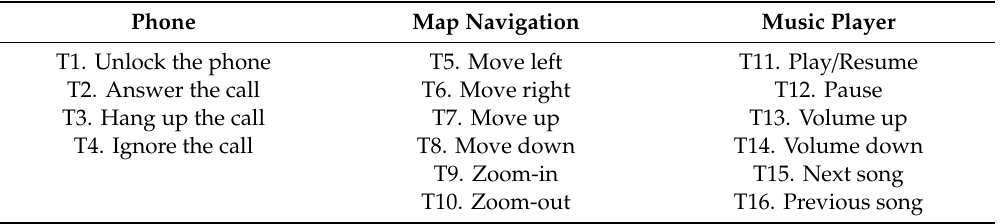
Table 1. 16 commands based on three di ff erent categories were used in our study. These tasks are the most performed on a touchscreen device as secondary tasks while